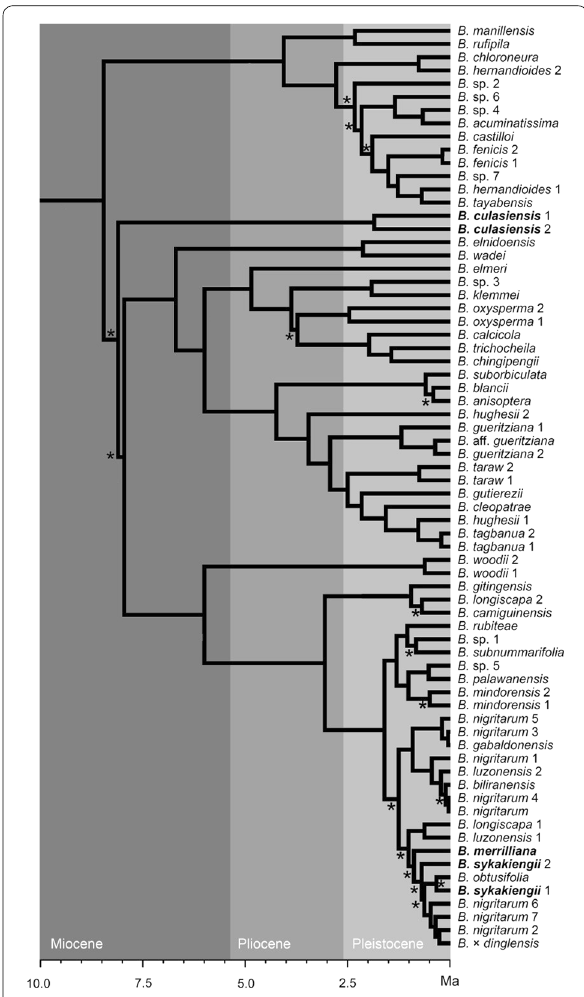
Fig. 10 A chronogram based on chloroplast DNA sequence data, taken from Hughes et al. (2015), with the three new species high‑ lighted in bold font . Geological epochs are indicated with three shades of grey in the background: light ; Holocene and Pleistocene (0–2.6 Ma); mid-grey , Pliocene (2.6–5.3 Ma); dark grey , Miocene (5.3–23.0 Ma). Asterisks mark clades with PP <